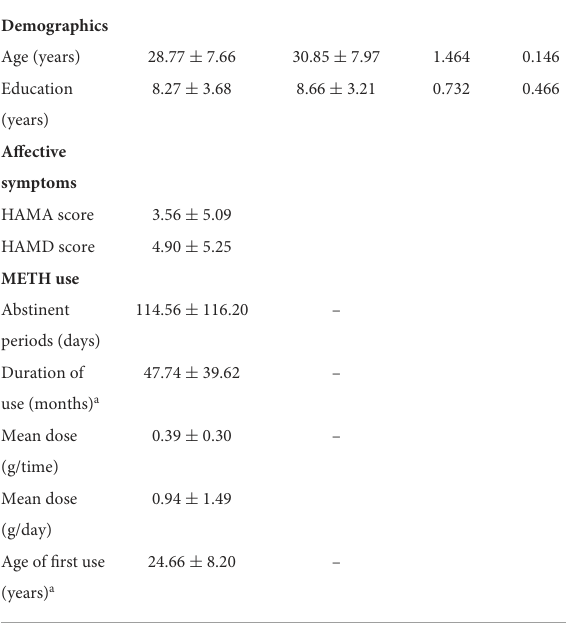
TABLE 1 Demographic and clinical data of the male abstinent MAs and